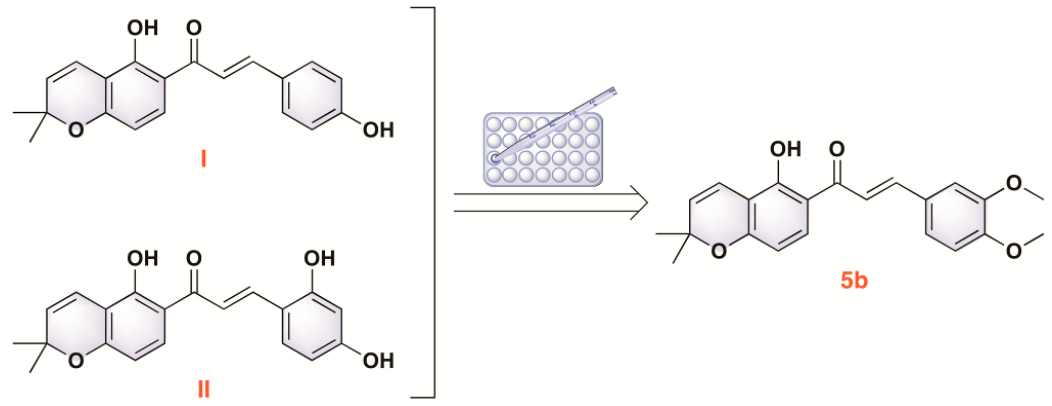
Figure 1. The chemical structure of 5b .